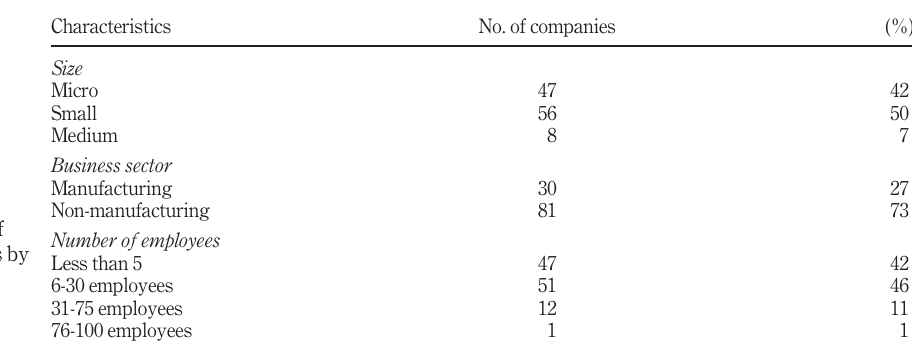
Table IV. Detailed pro fi le of SME respondents by size, number of employees and business sector